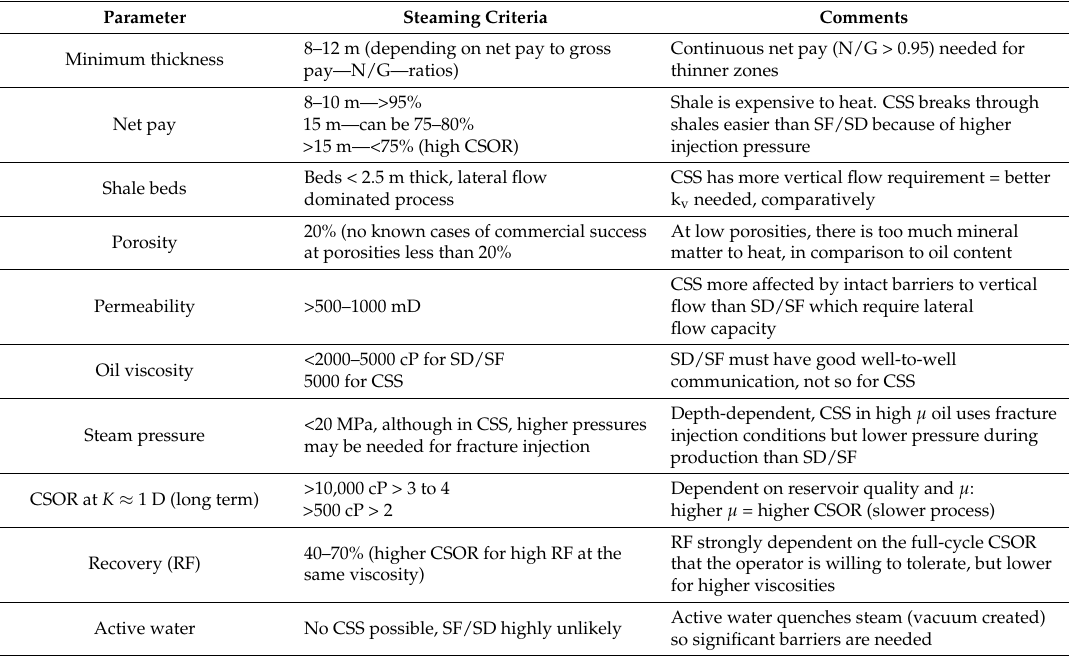
Table 1. Screening criteria for SF/SD/CSS in oil sands